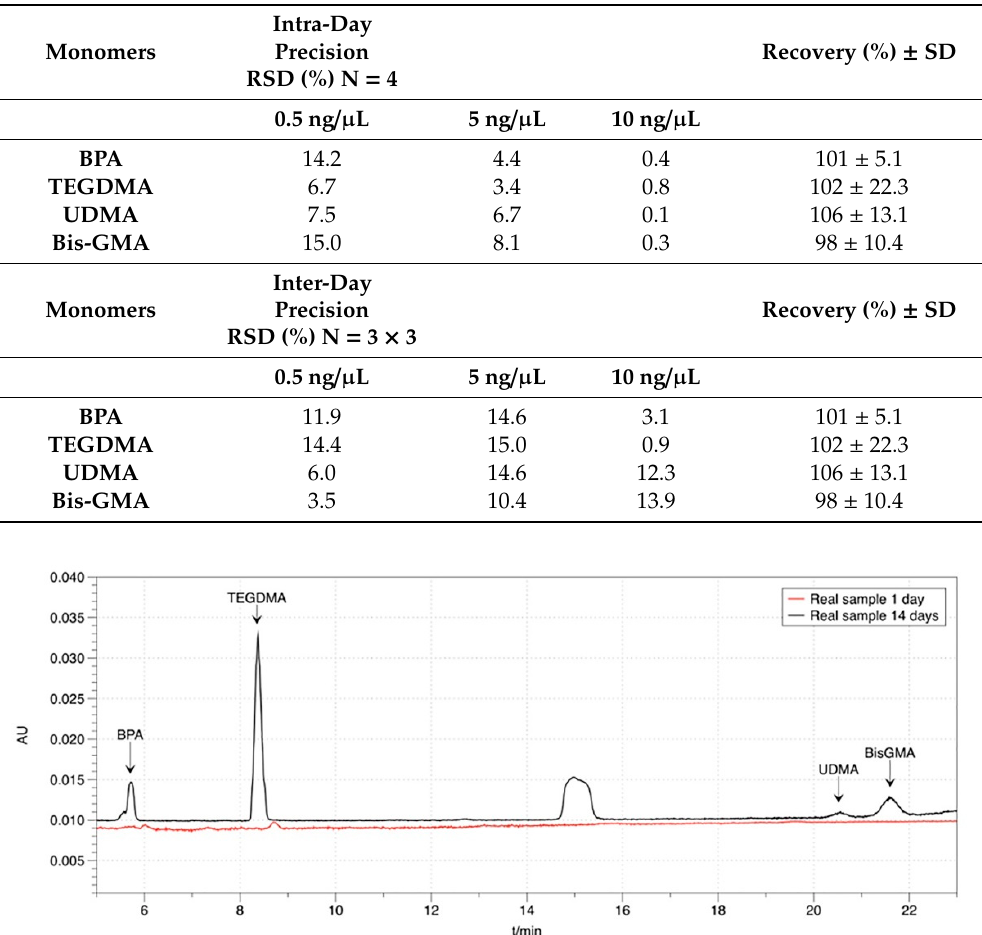
Table 3. Intra-day and inter-day precision and recovery (%) ± SD of the presented method.